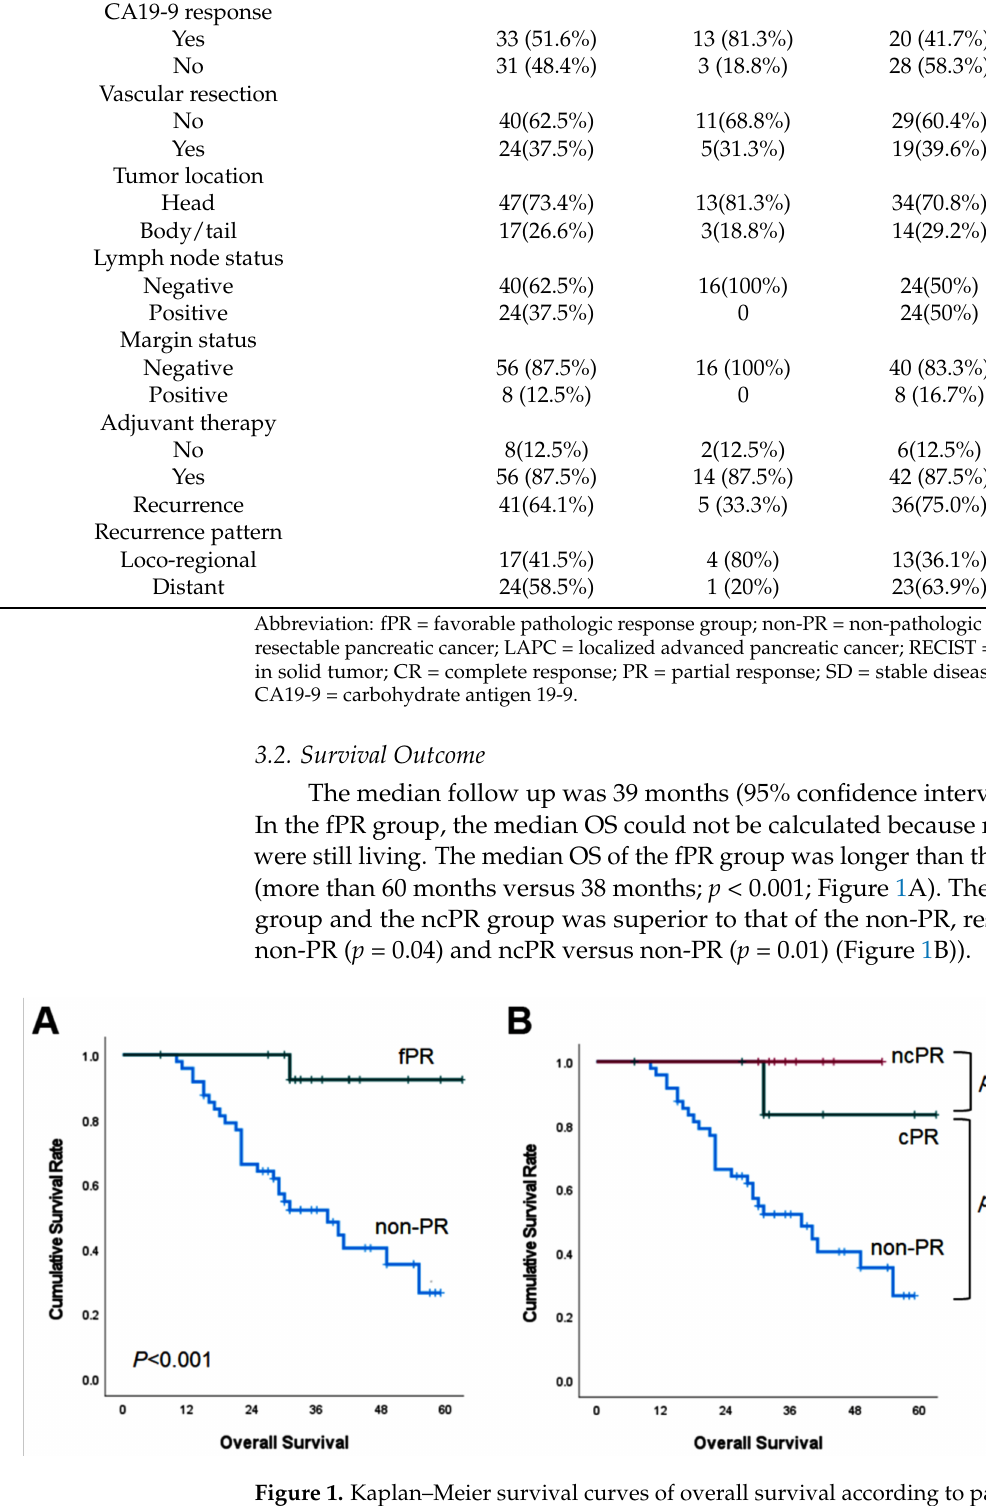
Figure 1. Kaplan–Meier survival curves of overall survival according to pathologic